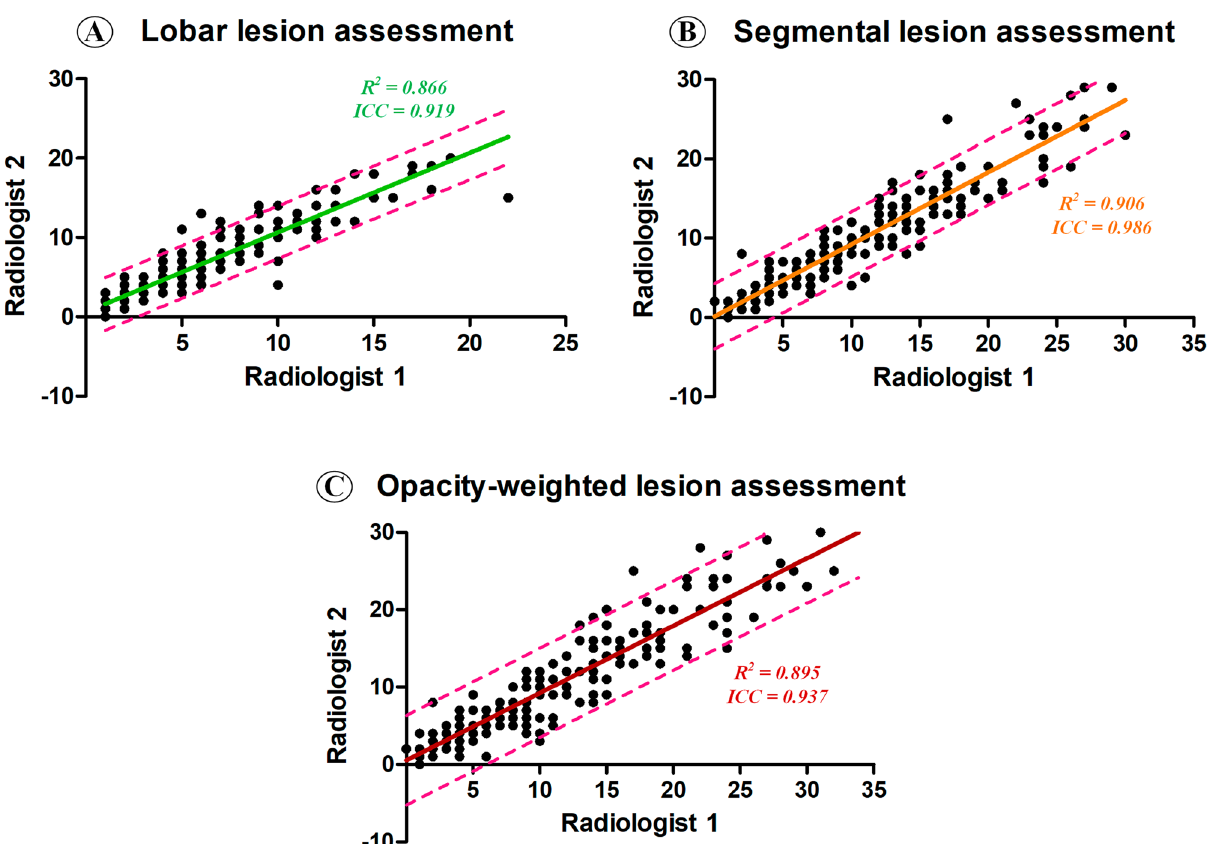
Figure 2. The correlation of semiquantitative lesion assessments between Radiologist 1 and Radiologist